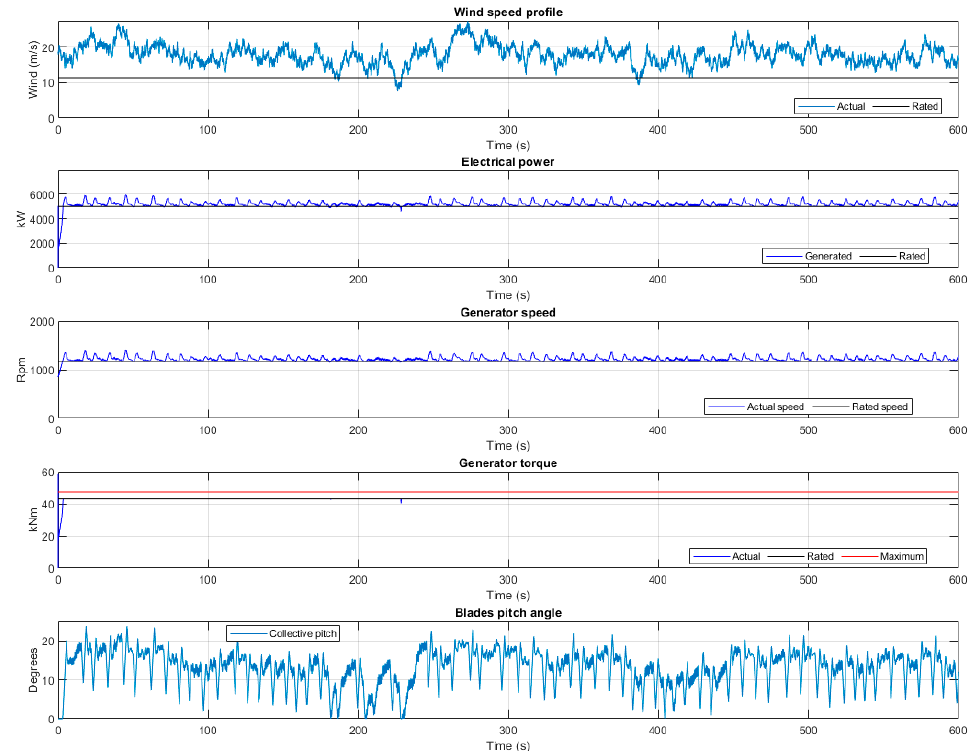
Figure 13. Simulation for improved PI with the Fuzzy Supervisor Control, under a wind profile of average speed of 18 m/s and turbulence A.